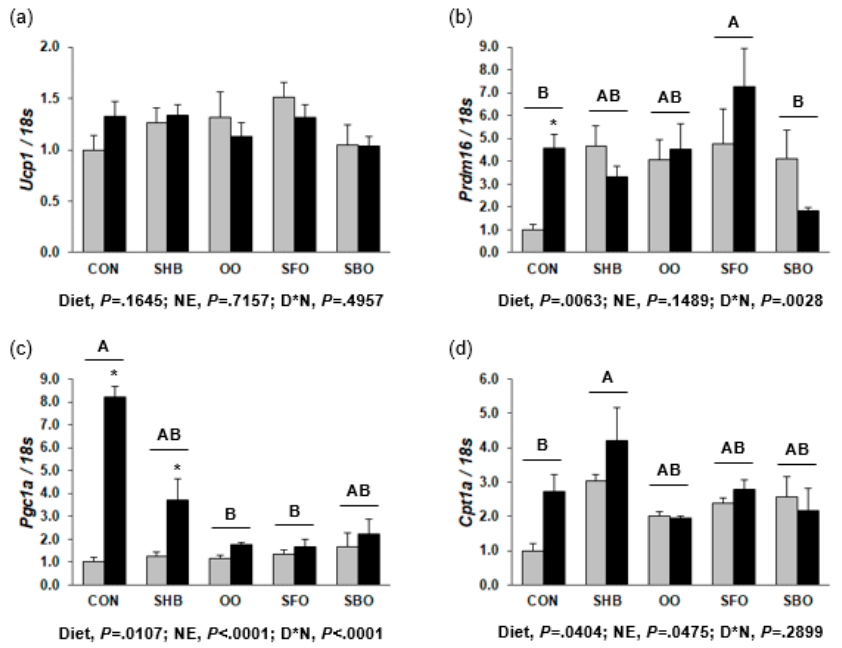
Figure 3. Expression of genes involved in thermogenesis in BAT ( a ) Ucp1 ( b ) Prdm16 ( c ) Pgc1a ( d ) Cpt1a . Mice were injected with norepinephrine (NE; 2 mg/kg body weight) or phosphate-buffered saline (PBS; 2 mL/kg body weight) as a vehicle after 8-h fasting at the end of the experimental period, and euthanized after another 4-h fasting. Gene expression was determined by RT-PCR. Bars represent means ± SEM ( n = 8 for each diet group; n = 4 each for PBS and NE treatment). Diets were compared among each other (after combining PBS and NE data within each diet), and assigned different superscripts A, B, AB, C, or D) if they were significantly different from each other at P < 0.05 by Tukey’s multiple comparison test. If a diet has a common superscript with another diet, it means they are not significantly different from each other. Only diets without a common superscript are significantly different from each other. D*N, Interaction effect between diet and NE. Asterisks (*) indicate significant differences caused by NE within each diet group when interaction effect was significant. CON, control; SHB, shea butter; OO, olive oil; SFO, safflower; SBO, soybean